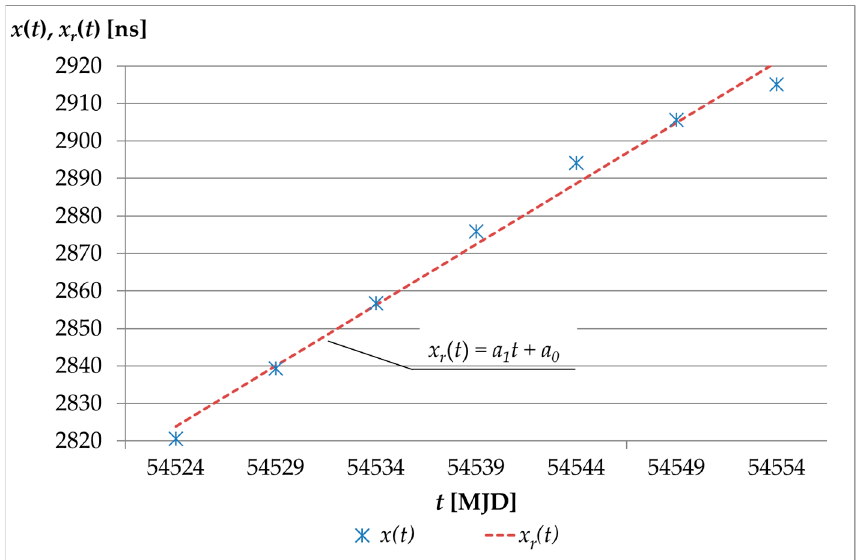
Figure 4. Sample set of the phase time x ( t ) and the trend x r ( t ) for a one-month period for